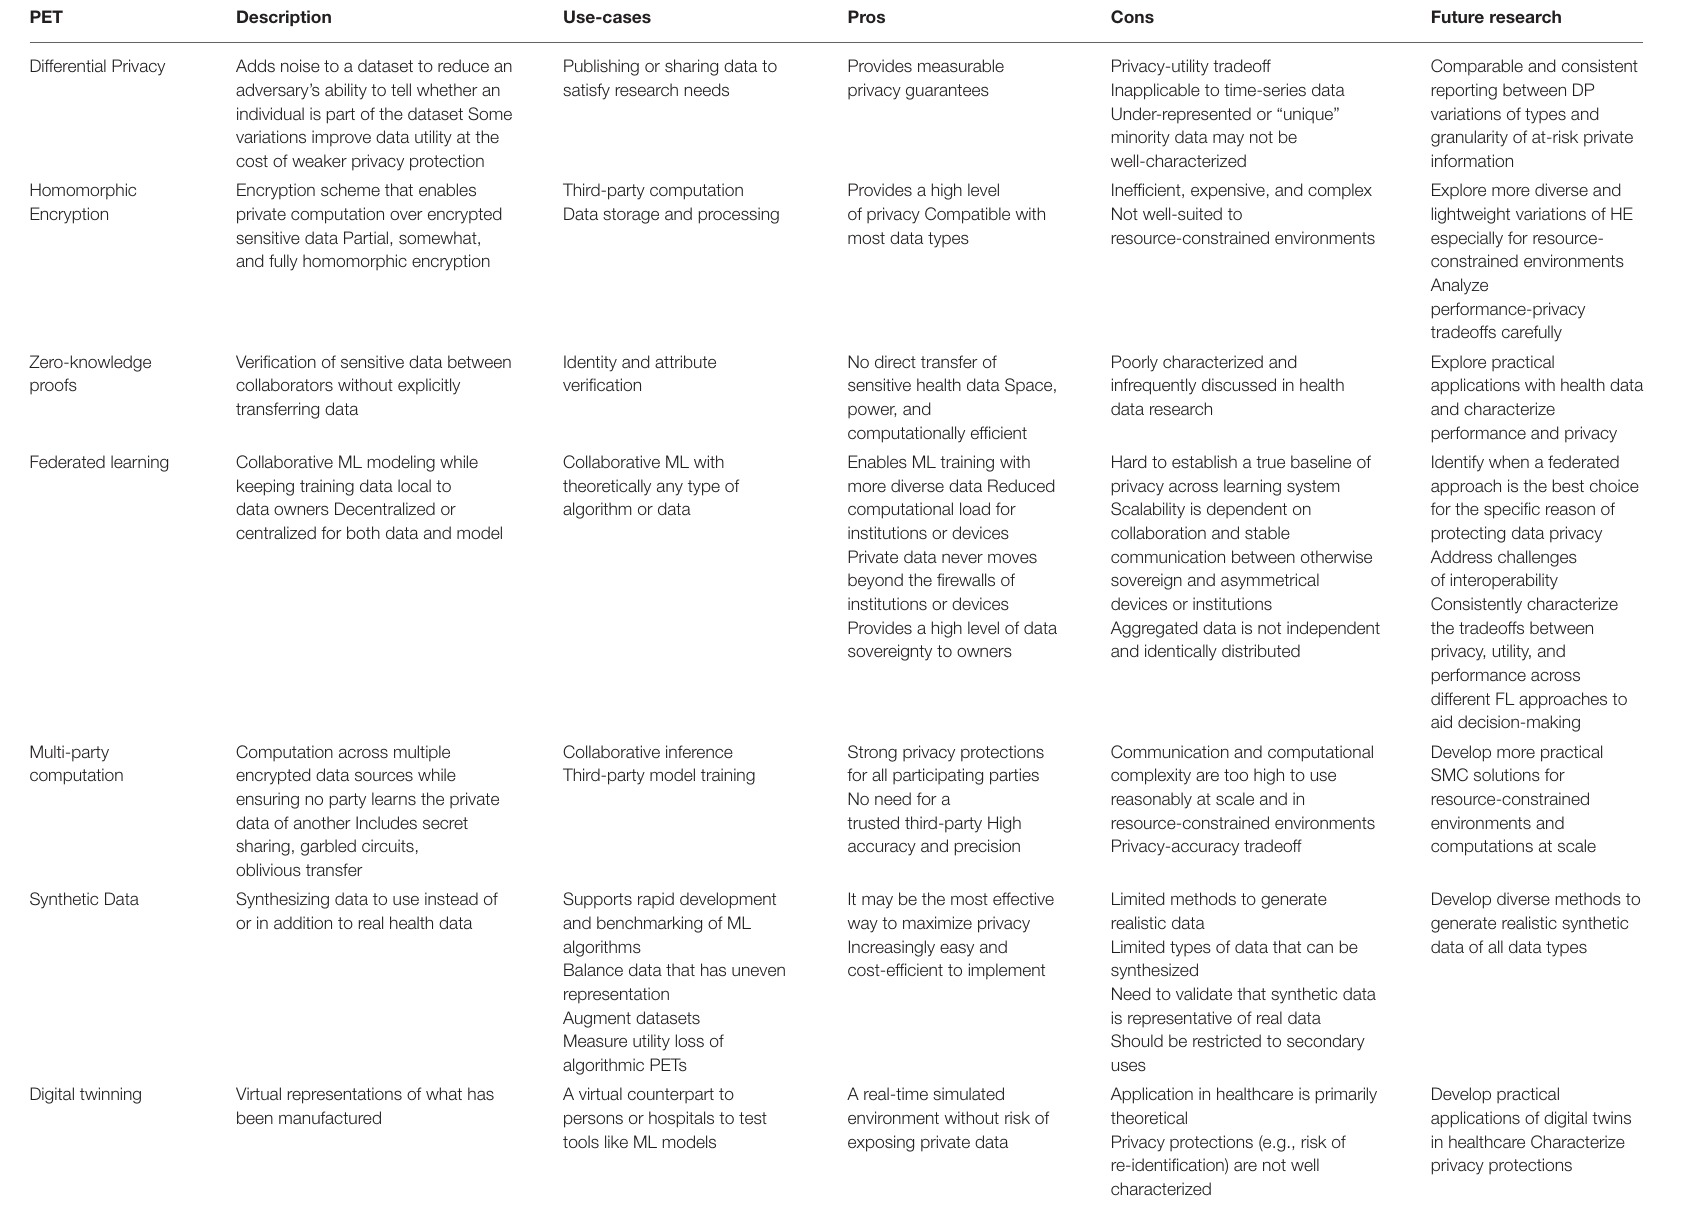
TABLE 3 | Key characteristics and considerations for each pet.